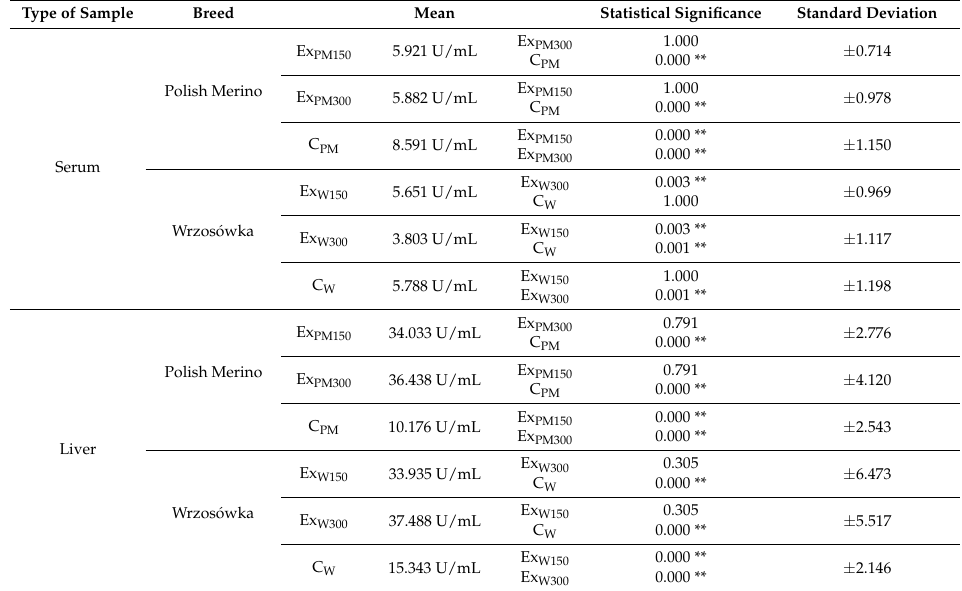
Table 1. Activity of superoxide dismutase (U/mL) in serum and liver samples collected from both breeds as affected by the dose of the